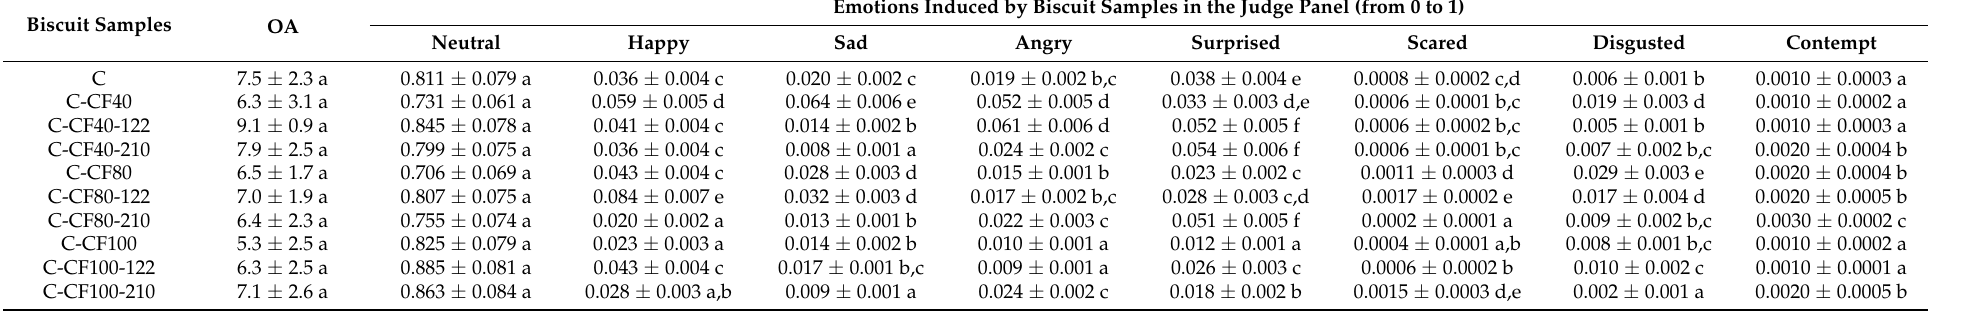
Table 7. Overall acceptability (OA) and emotions induced by biscuit samples in the judge